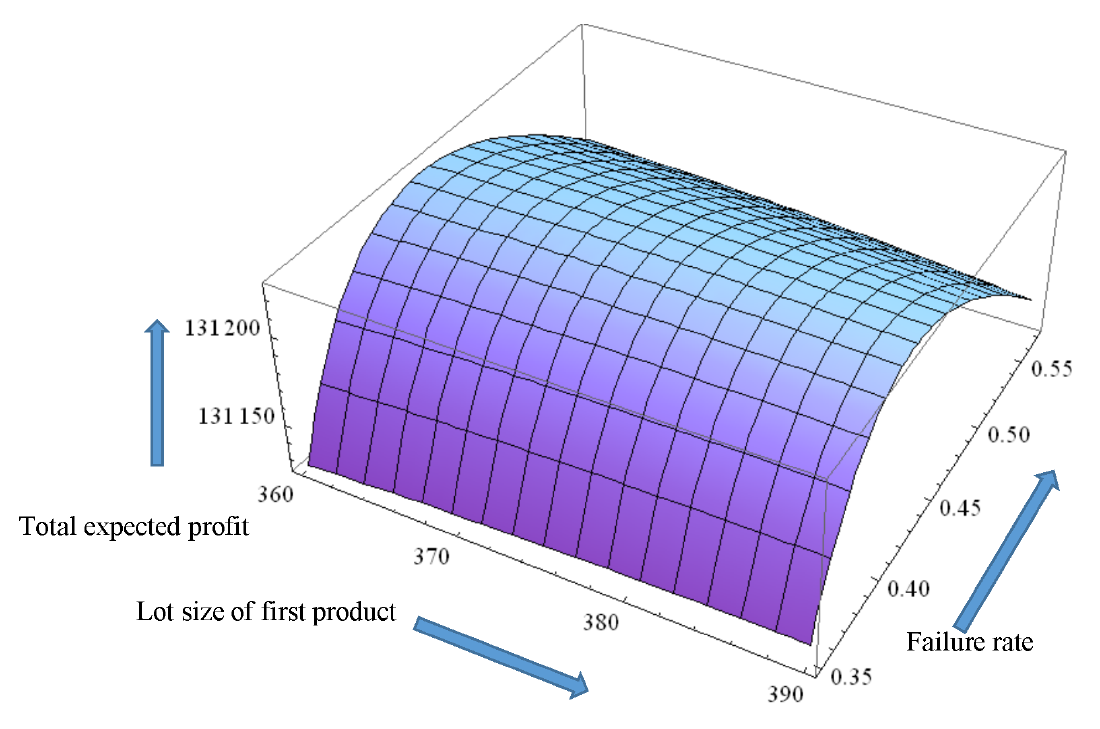
Figure 7. Expected total profit (ETP) versus lot size of first product Q 1 and failure rate η